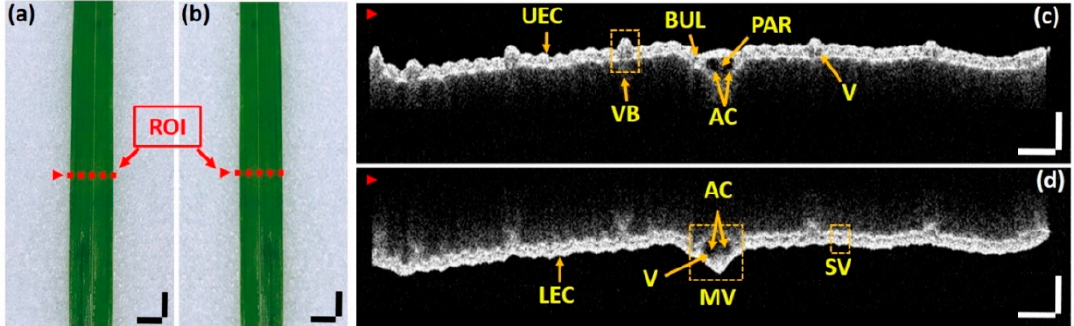
Figure 4. Comparison of two-dimensional SS-OCT images of the front and rear surface of the rice leaf specimens: ( a , b ) shows the front and rear surface of the rice leaf specimens. The red dotted line indicates the region of interest along with the scanning direction. The sub-figures ( c , d ) exhibit two-dimensional SS-OCT images of ( a , b ). Lateral and vertical scale bars: 500 µ m. AC: Aerenchyma, BUL: Bulliform cells, LEC: lower epidermis cells, MV: mid-vein, PAR: parenchyma, SV: small vein, UEC: upper epidermis cells, V: vacuum region and VB: vascular bundle.